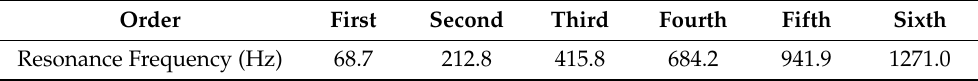
Figure 6. First vibration mode in modal analysis for system configuration having cantilever length of 40 mm, thickness of 1 mm, and breadth of 20 mm.